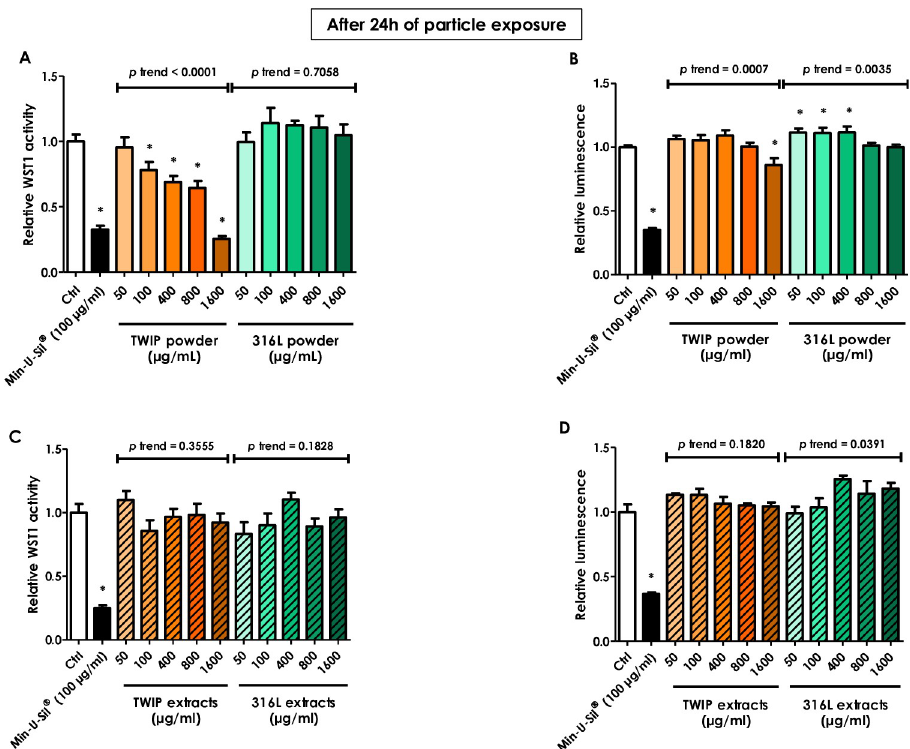
Fig 3. HUVECs WST-1 activity is dose-dependently reduced by direct exposure to TWIP steel particles. HUVECs were grown in 96-well transparent or white plates and exposed the next day to different concentrations of TWIP steel or 316L steel particles or extracts for 24h. Extracts were obtained from culture medium incubated during 24h with the same concentrations of particles. The cells were then washed and further incubated in fresh medium with 10% WST-1 reagent for 2h. Absorbance was measured at 450 nm, with 690 nm as reference (A, C). After 24h exposure and wash, the white plate was replenished with fresh medium containing the CellTiter-Glo 1 reagent (ATP) and luminescence was read (B, D). Results are reported as relative WST-1 activity or luminescence, where 1.0 corresponds to the value measured in control cultures. Min-U-Sil 1 was used as a positive control. Values are means ± SEM (n = 8), � p < 0.05 relative to control (One-way ANOVA followed by a Dunnett’s multiple comparison). The trend test included controls.